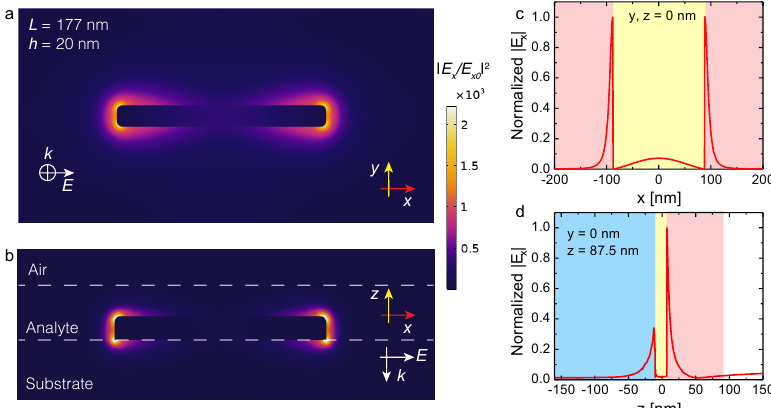
Figure 4. The electric field enhancement | E x / E x 0 | 2 distribution around the gold NP in an array ( Λ 1 = 400 nm and Λ 2 = 200 nm) surrounded by NMA layer: top view ( a ) and side view ( b ). Normalized electric field distribution along the x -axis goes through the NP center ( c ); the same for the z -axis ( d ) at x = 87.5 nm. Color encoding in ( c , d ): blue—the BK-7 glass substrate, yellow—gold nanoparticle, red—thin layer of NMA layer, white—air. The excitation wavelength is λ = 1494 nm. The colorbar corresponds for colormaps in ( a , b )